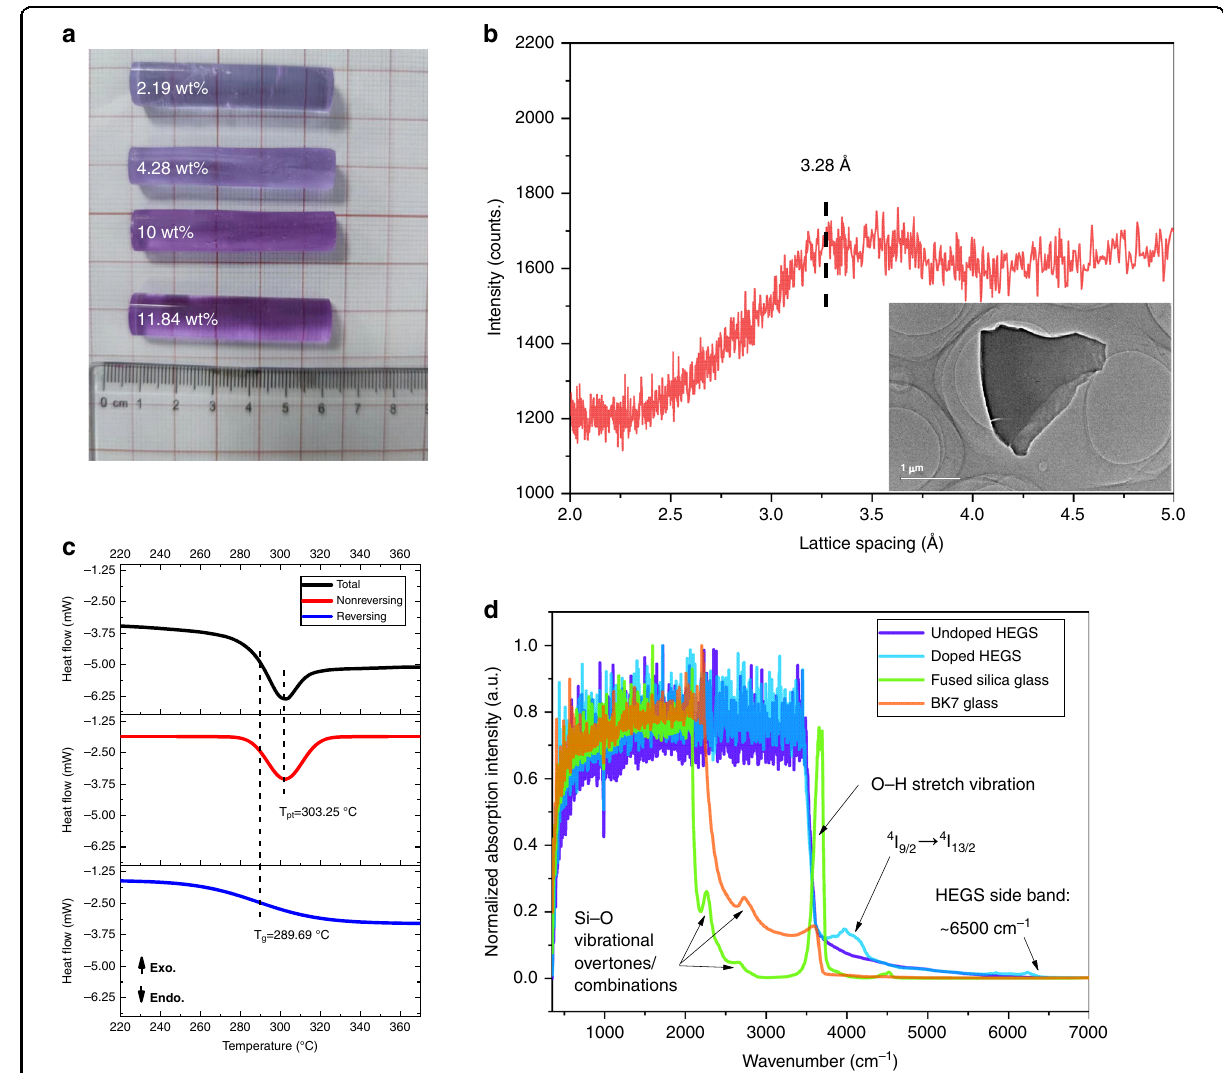
Fig. 1 Structure, thermodynamics, and spectral properties of HEGS. a Photo of HEGS samples with varying doping concentrations. b The intensity-interplanar relationship of the HEGS system, derived from the original intensity-diffraction angle relationship from X-ray diffraction measurement. The inset is the TEM micrograph of the HEGS sample. c DSC result of one HEGS sample. When the sample was heated to around 300 °C, a non-reversing endothermic peak was present, accompanying the reversing vitri fi cation process. Isolation of the two processes was accomplished by peak fi tting. d The infrared absorption of different samples with a thickness of 3-4 mm. For fused glass, the peak at 2200 cm − 1 results from the double-frequency peak of Si-O-Si vibration mode at 1104 cm − 1 . The peak at 2670 cm − 1 results from the double-frequency peak of Si-O-Si vibration mode at 795 cm − 1 and the sum-frequency peak of Si-O-Si vibration mode at 1104 cm − 1 . The peak at 3654 cm − 1 is assigned to the O-H due to the adsorption of water on the fused silica. Overtones with higher frequency is unlikely to appear and the allowable overtones or combinations are limited. Hence, the absorption of fused silica glass is weak between 2000 cm − 1 and 3800 cm −